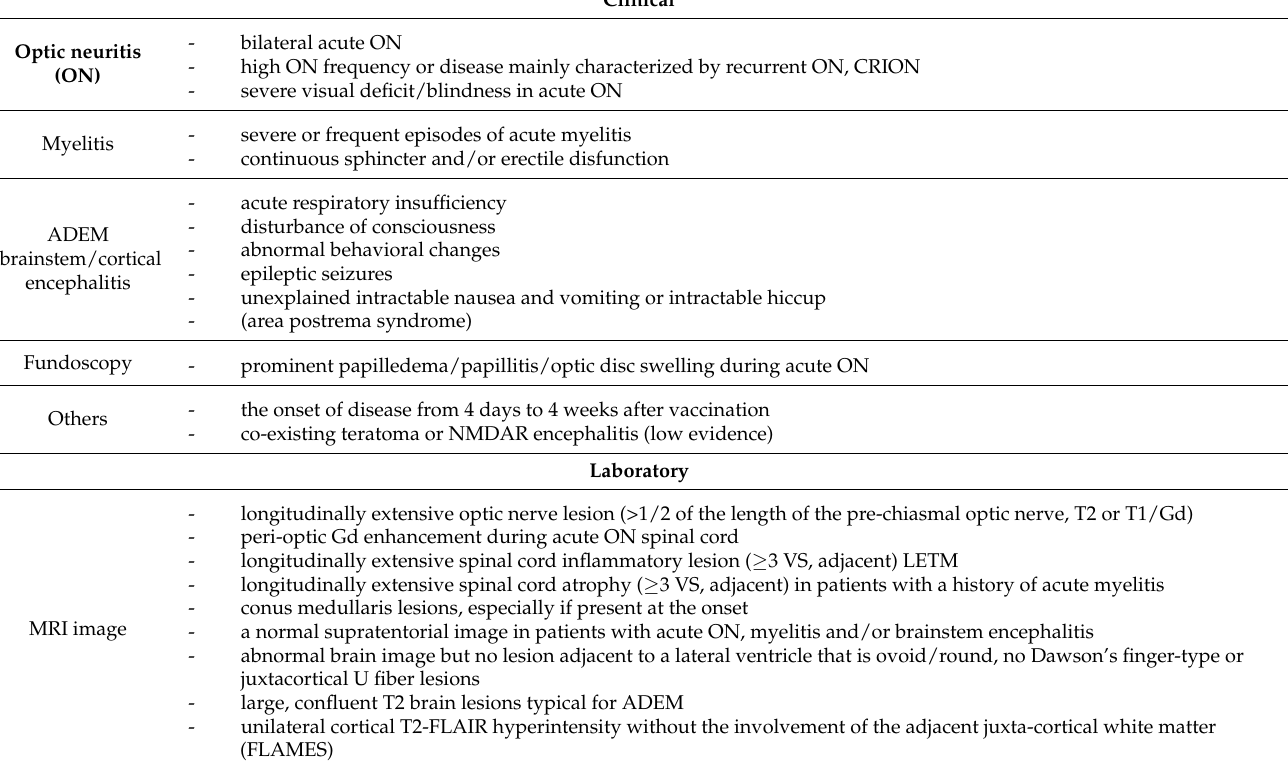
Table 2. MOG -IgG testing in MOGAD